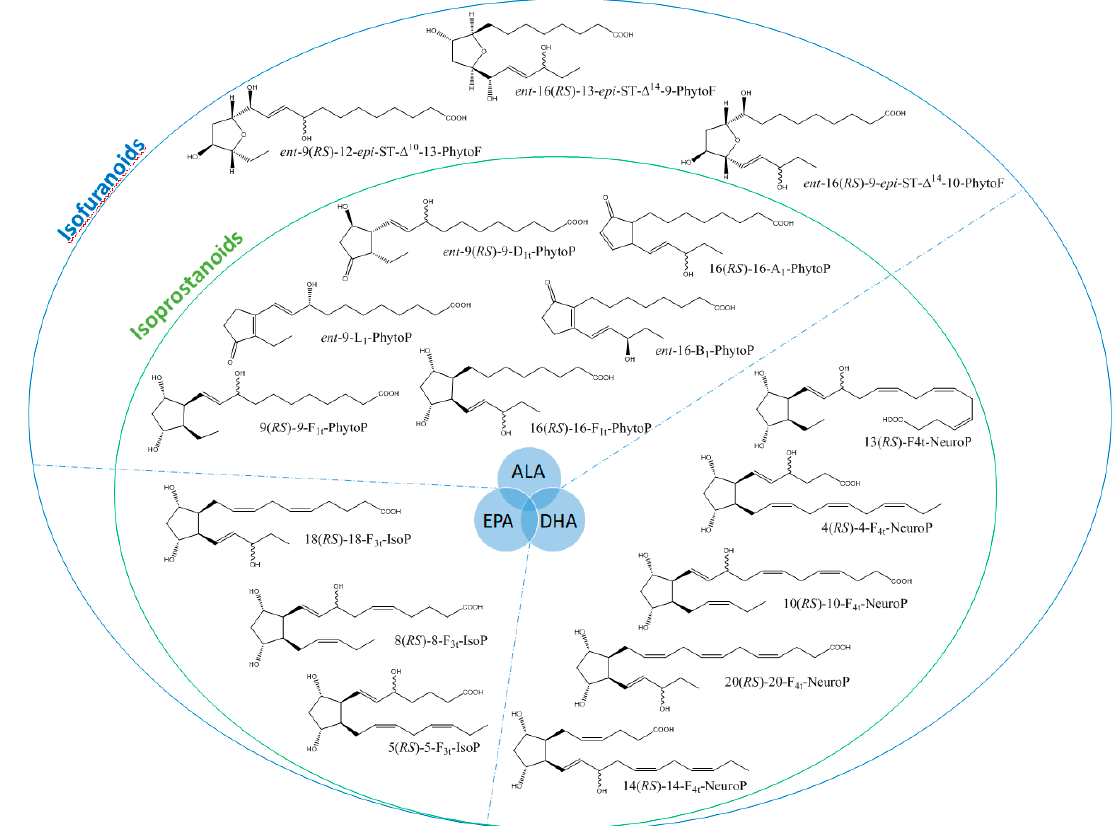
Figure 1. Structure of some isoprostanoids isomers derived from n-3 polyunsaturated fatty acids (PUFAs): ALA ( α -linolenic acid), EPA (eicosapentaenoic acid) and DHA (docosahexaenoic acid).